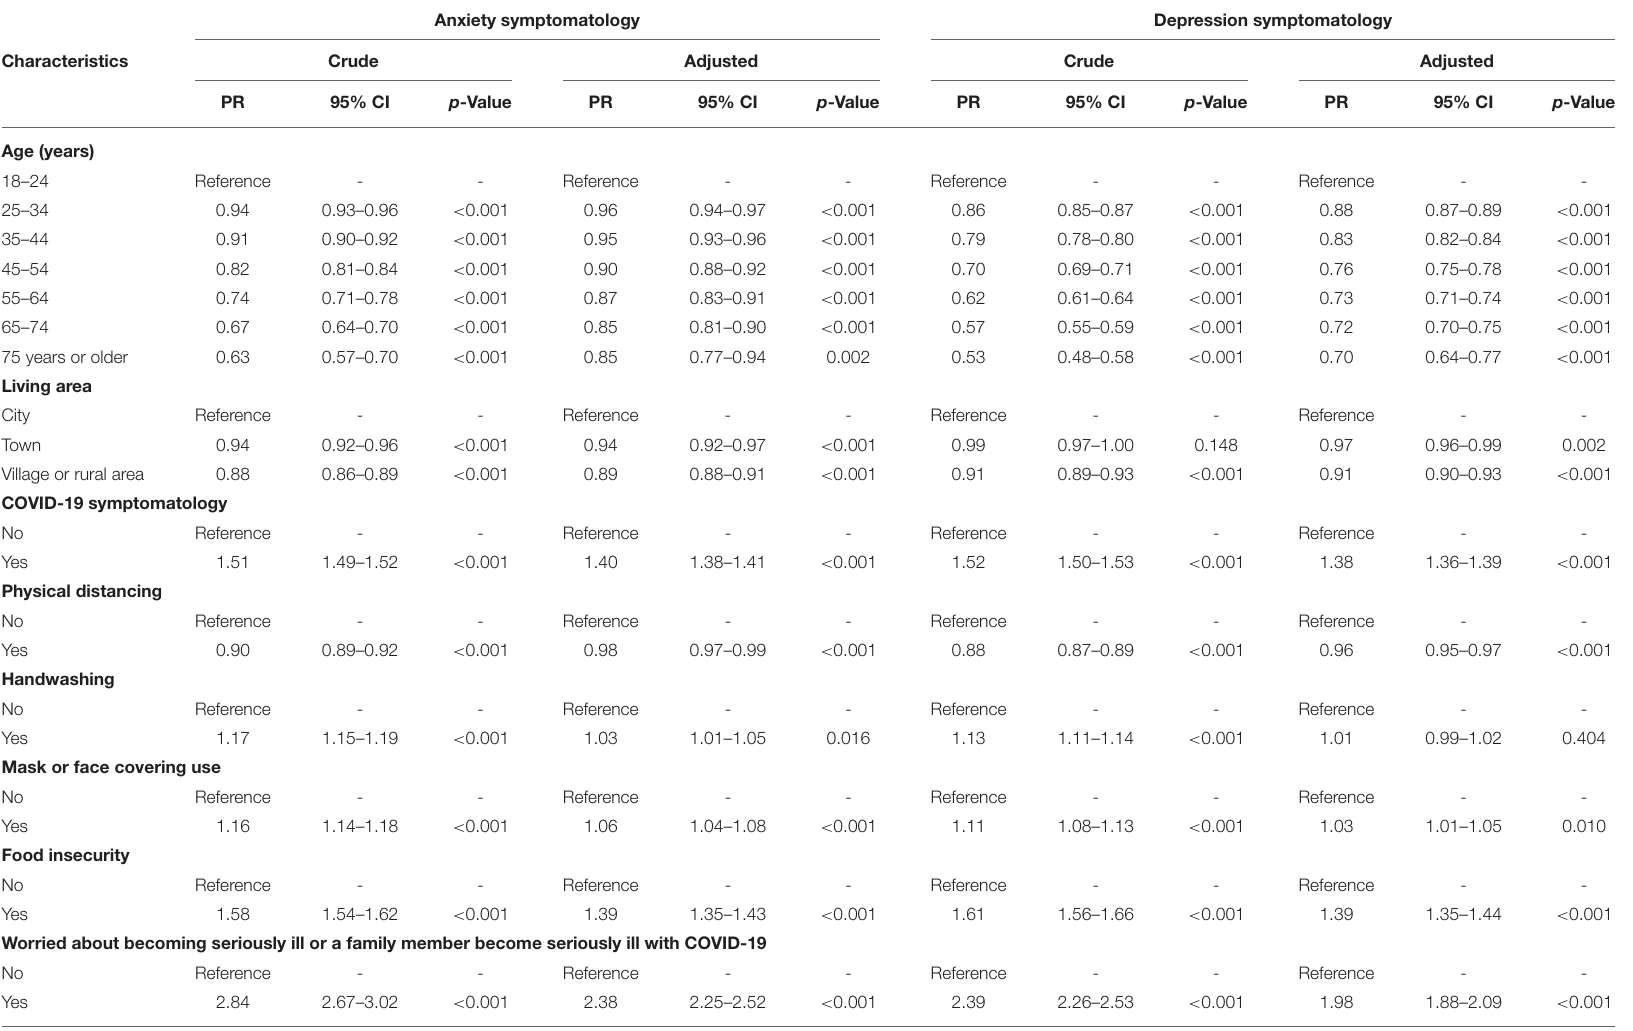
TABLE 5 | Crude and adjusted generalized linear models of Poisson family with logarithmic link to evaluate the factors associated with anxiety or depression in women